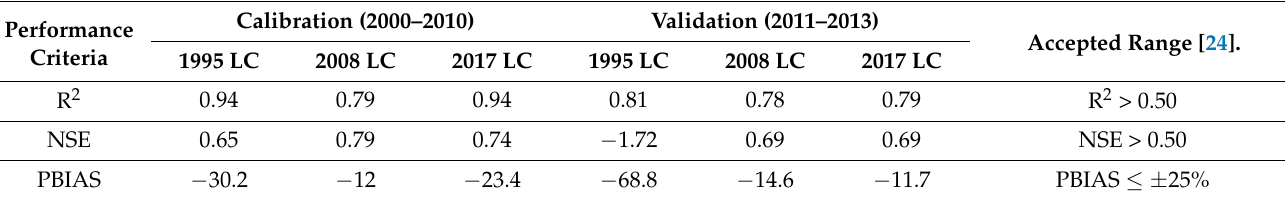
Table 4. Summary of calibrated and validated performance